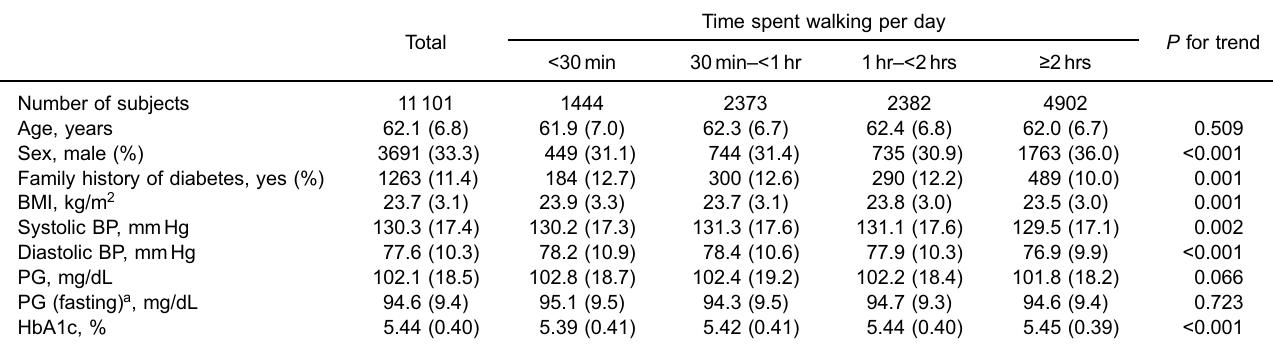
Table 4. Baseline characteristics of study participants according to time spent walking per day (longitudinal analysis)